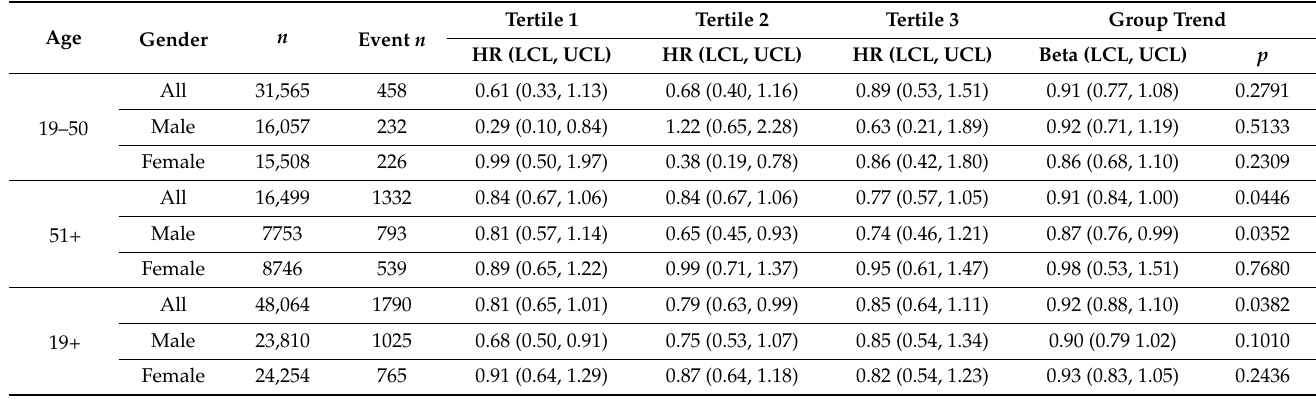
Table 7. Cancer mortality hazard ratio associations with low-calorie sweeteners, 1988–2018. Data are hazard ratios (HR) and 95th percentile confidence lower (LCL) and upper (UCL) levels. Cox proportional hazards regression was used to estimate HR and 95th percentile confidence levels for cancer mortality. HRs were estimated by assigning nonconsumers of aspartame/saccharin/LCS to the reference group (HR = 1.0). LCS consumers were then split by tertiles of consumption T1, T2, and T3, using SAS 9.4 PROC SURVEYPHREG with age, sex, race/ethnicity, education, current smoking status (Y/N), alcohol consumption, physical activity level, and BMI (continuous) as covariates. Data adjusted for complex sample design of NHANES and used relevant sample